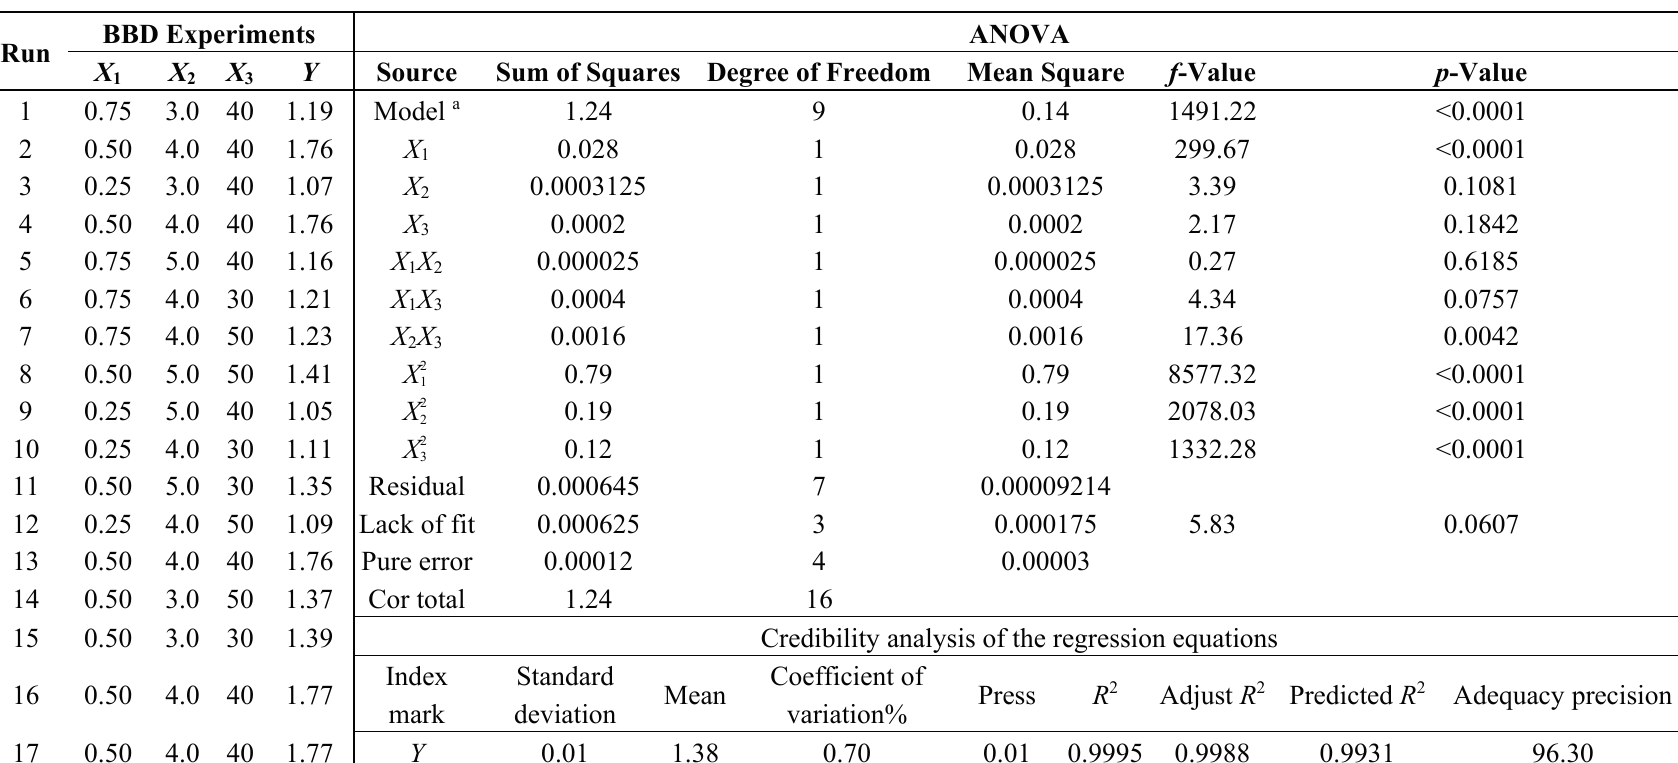
Table 1. Experimental design matrix to screen for variables that determine the yield of genipin and ANOVA